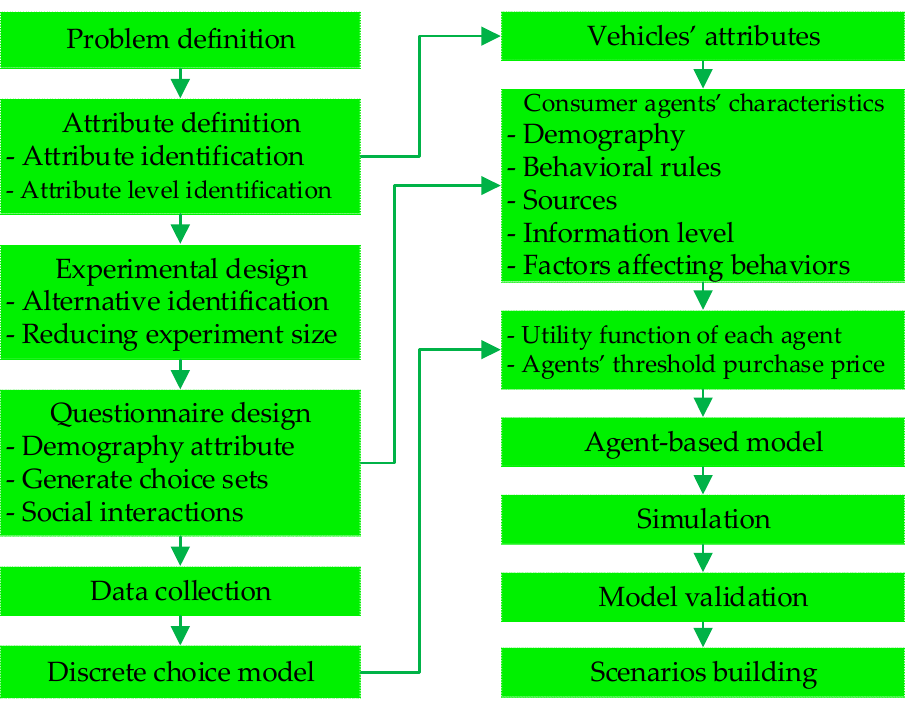
Figure 1. Research